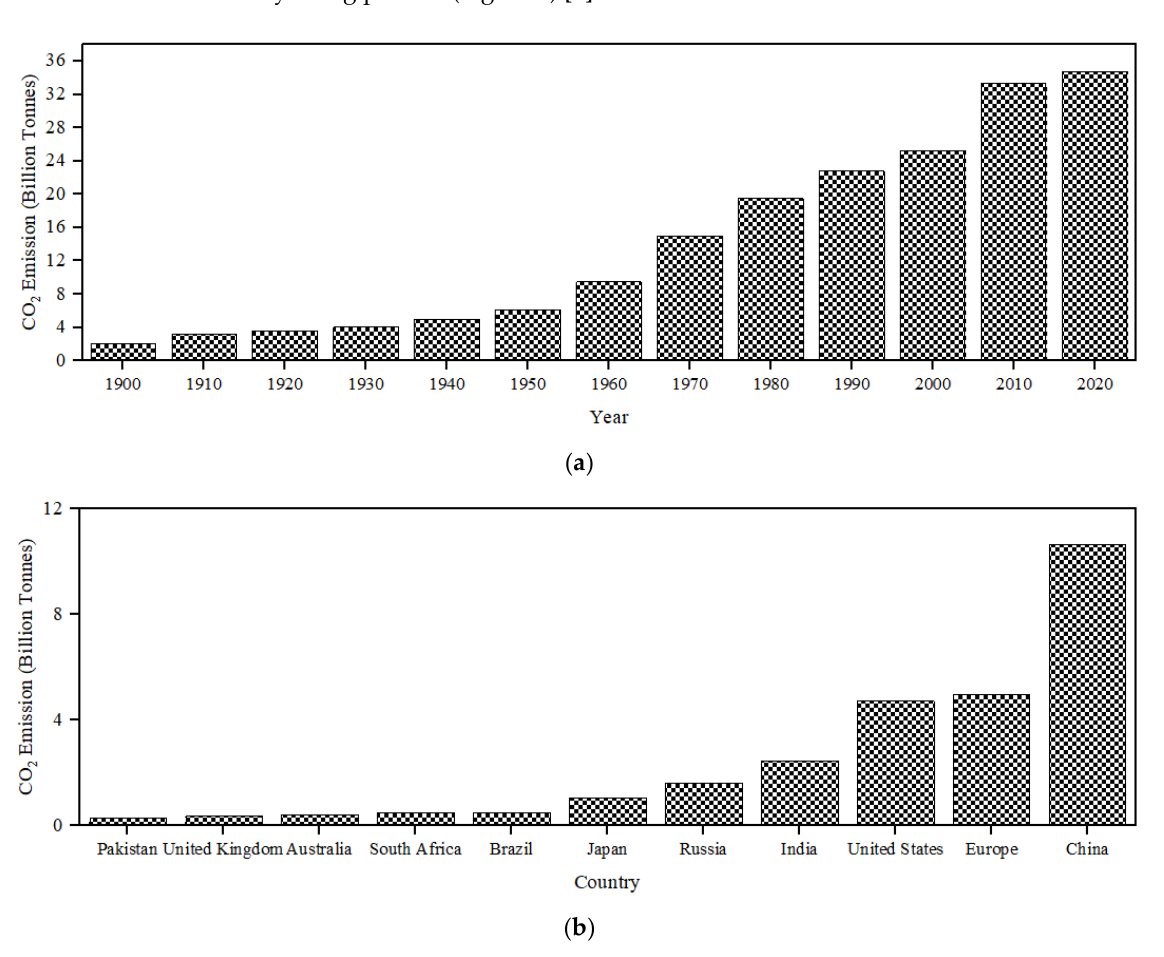
Figure 1. The global CO 2 emission ( a ) for the last century and ( b ) country/region-wise emission levels.